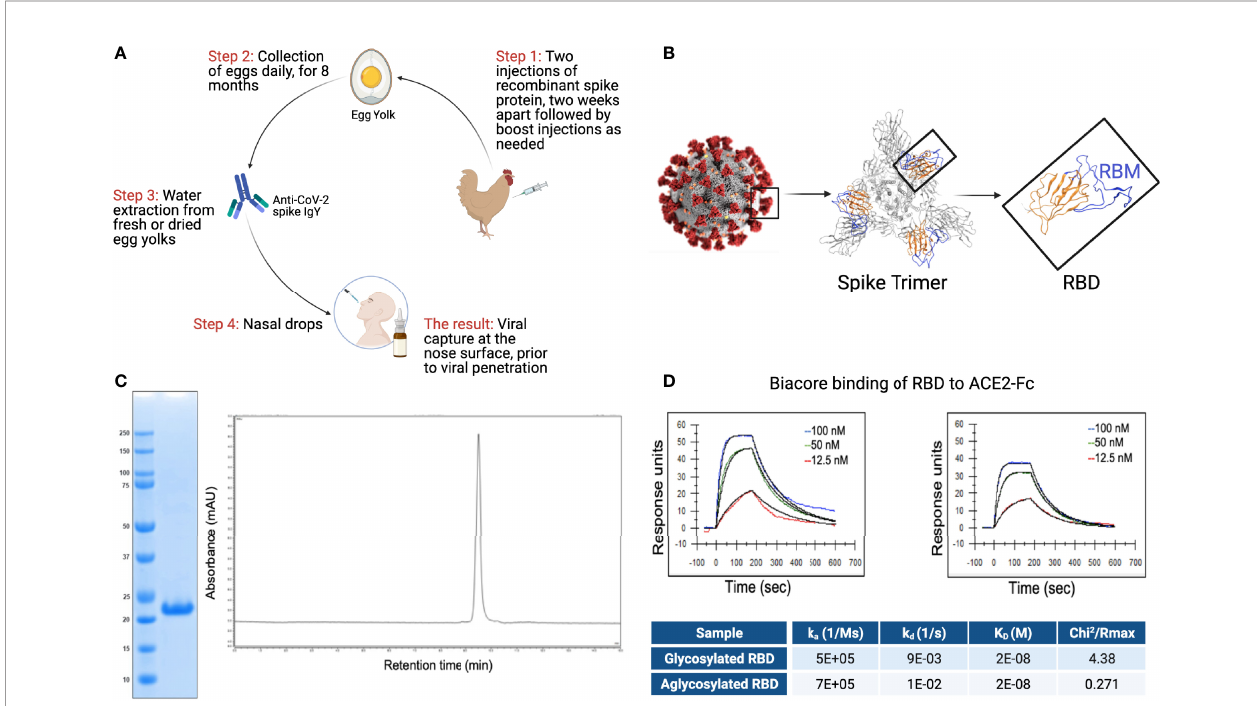
FIGURE 2 | RBD and IgY preparation. (A) Work fl ow of the study. IgY preparation for intranasal drops as antiviral prophylaxis. (B) Cell-free expressed RBD derived from the Spike protein on the viral envelope of SARS-CoV-2. (C) Characterization of the recombinant protein RBD by ELISA and HPLC. (D) Determination of the af fi nity of the cell-free expressed RBD (amino acids 328-533) and mammalian-expressed full-length S1 to the hACE2 using